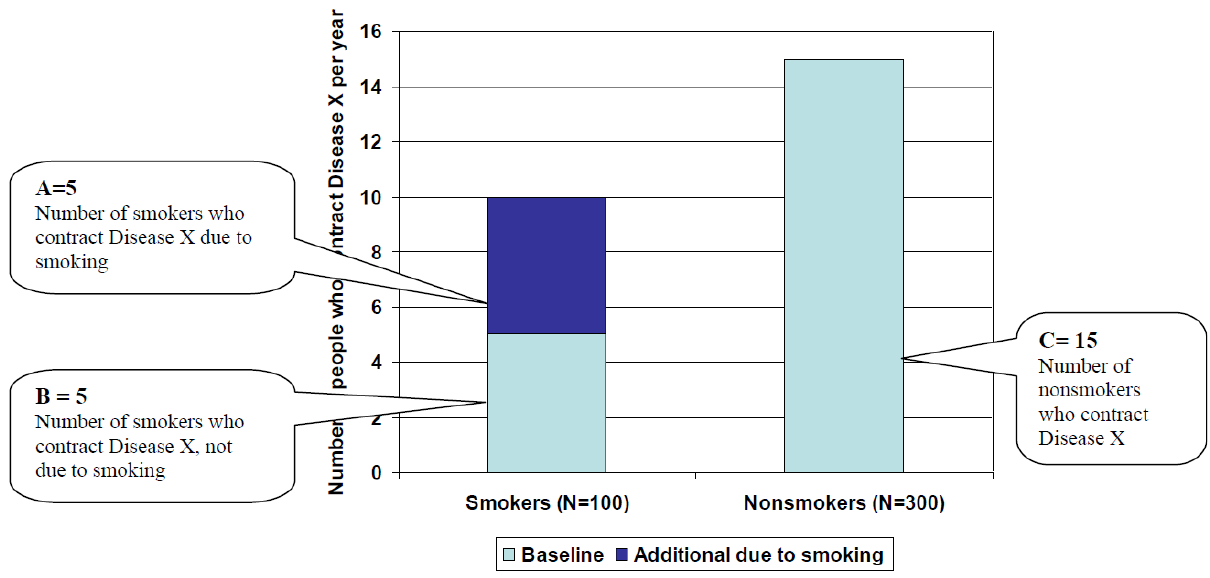
Figure 2. Number of smokers and nonsmokers who contract